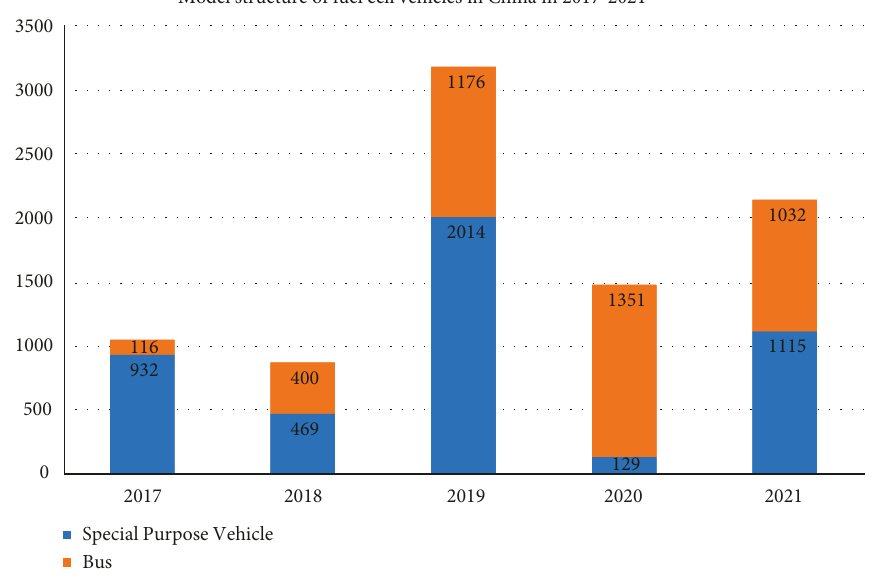
Figure 5: Model structure of fuel cell vehicles in China in